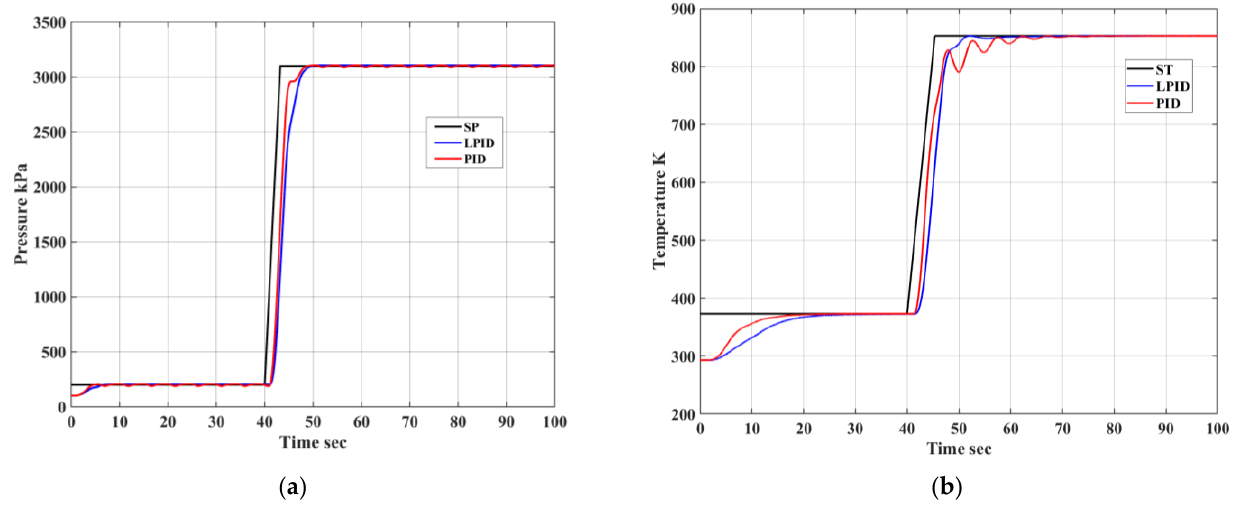
Figure 5. Dynamic response simulation with the PID and LPID controllers of ( a ) a huge range of pressure variation; ( b ) a huge range of temperature variation.